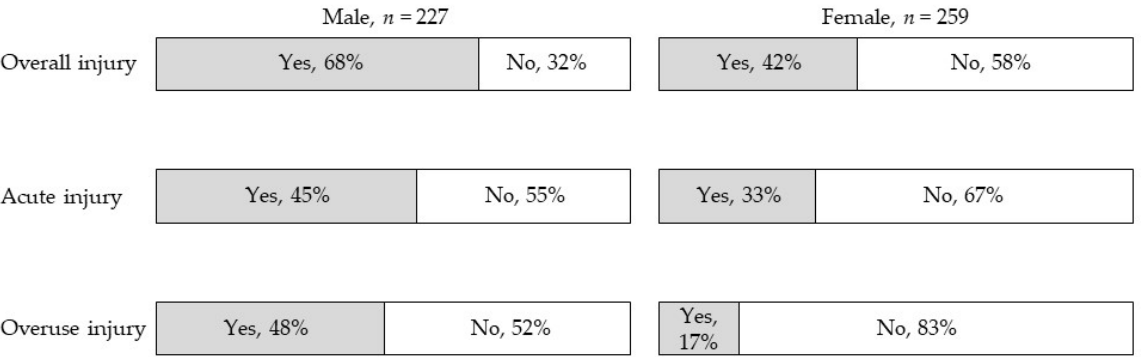
Figure 3. Prevalence of sports-related injuries in the lifetime. All proportions with injuries in males were significantly higher than those in females ( p < 0.01).